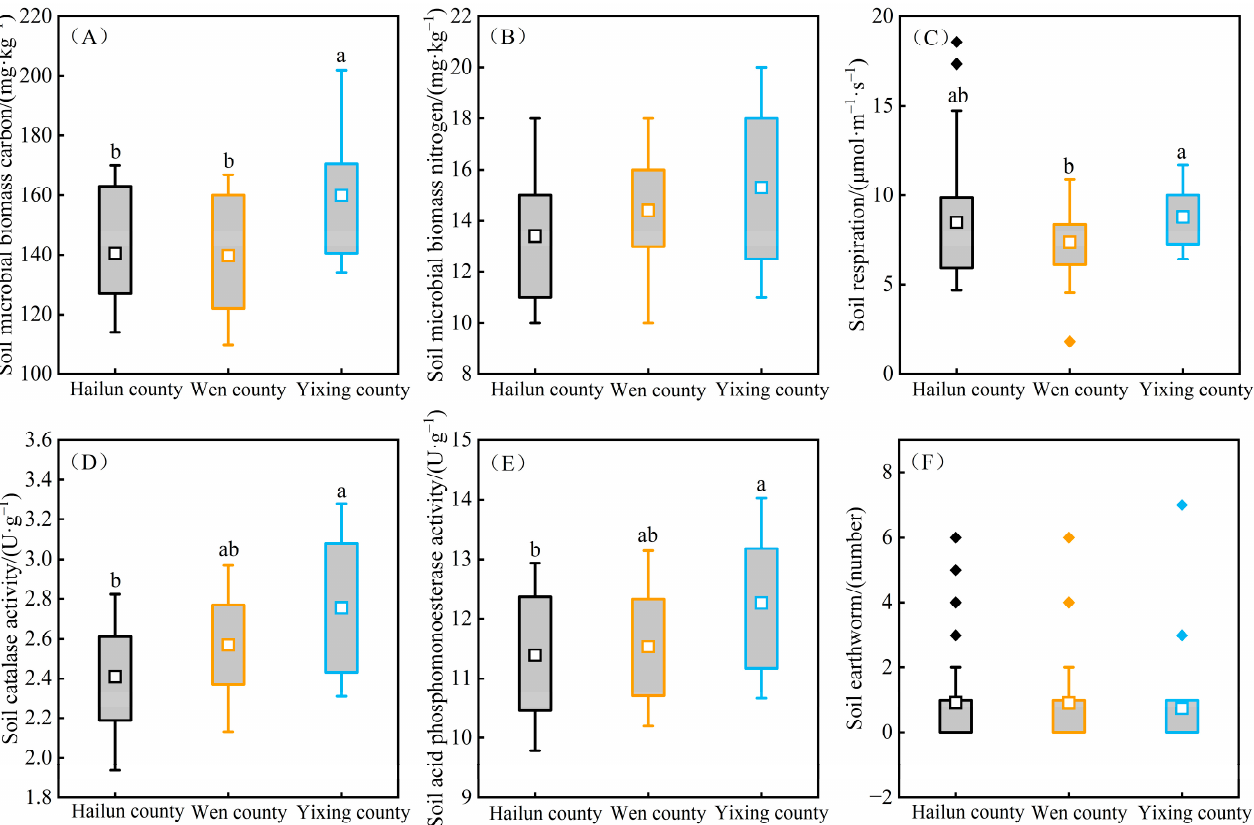
Figure 2. Distribution of data on soil biological indicators for typical farmland in the different regions. Subplots ( A – F ) represent the range and variability of data distribution for six soil bioindicators from three different regions. Where black boxes indicate Hailun County, yellow boxes indicate Wen County and blue boxes indicate Yixing County; lowercase letters indicate significant differences at the 0.05 level (n = 3).